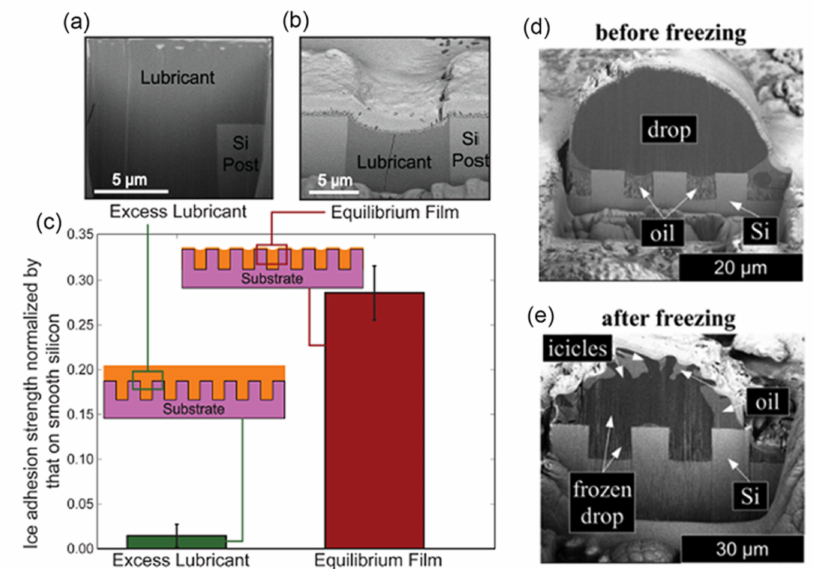
Figure 10. Cryo-stabilized SEM images of an FIB-cut lubricant-impregnated surface with ( a ) excess and ( b ) equilibrium films. ( c ) Comparison of the ice adhesion strength on lubricant-impregnated surfaces having excess and thermodynamically stable lubricant films. Cryo-FIB/SEM images of drops before ( d ) and after ( e ) freezing. The sample-holder assembly was cooled from room tem- perature to about − 10 ◦ C, and the relative humidity varied from 30 to 40%. ( a – c ) reproduced with permission from [223] and ( d , e ) reproduced with permission from [224], Copyright 2013 American Chemical